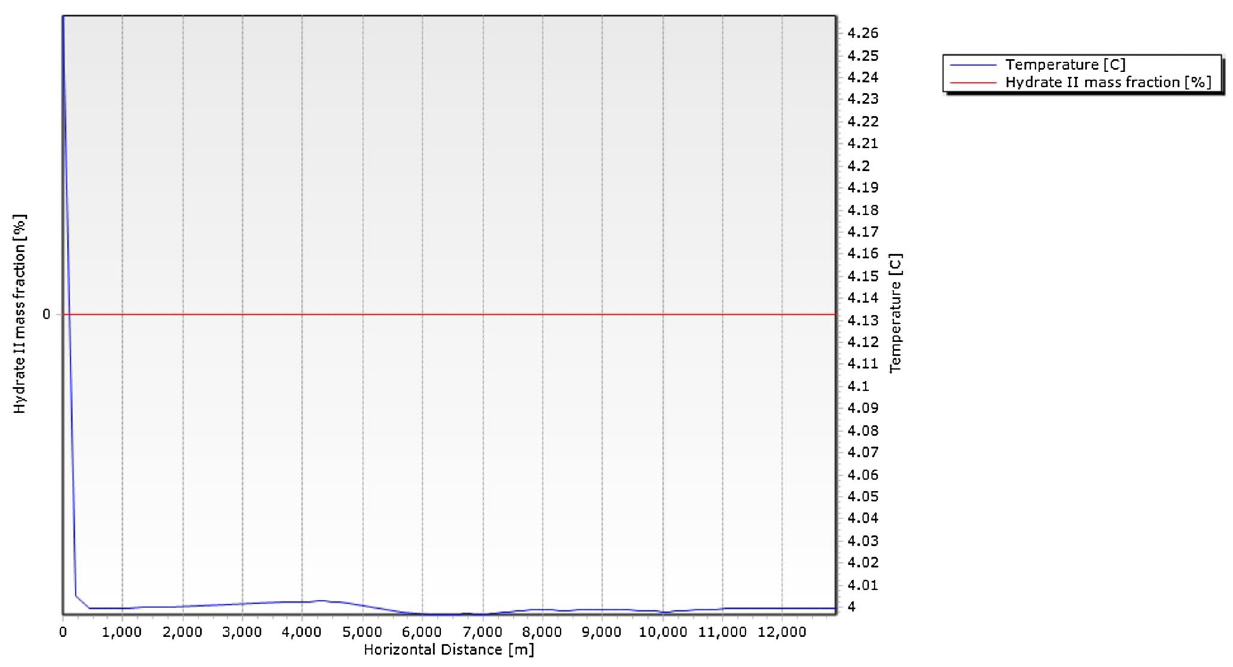
Fig. 15 Pipe profile showing hydrate mass fraction after injection of kinetic hydrate inhibitor